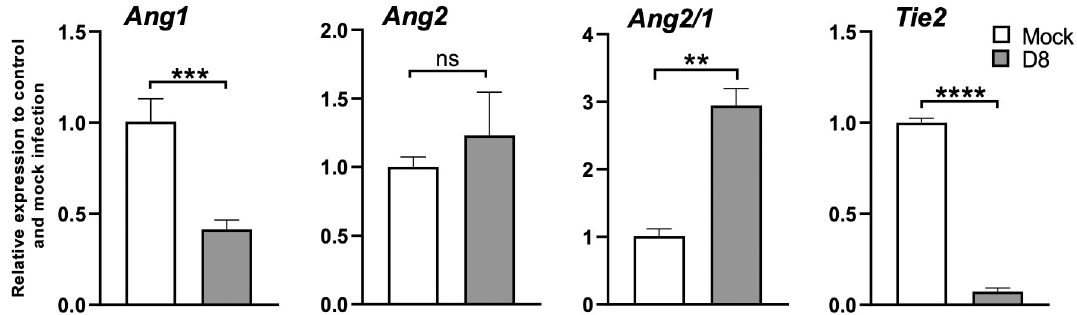
Fig 4. Lung endothelial dysfunction in CD-1 mice during acute infection. CD-1 mice were infected, as described in Fig 2. Lung tissues were collected from mock and day 8 infected mice (3–4 mice/group), and RT-qPCR assays were performed to measure Ang1 , Ang2 , and Tie2 levels, shown as relative to GAPDH values. The Ang2/Ang1 ratio of individual samples was calculated based on RT- qPCR data and compared to mock controls. Data are presented as mean ± SEM. Students T-test was used for statistical analysis. ns = not significant; �� , p < 0.01; ��� , p < 0.001; ���� , p < 0.0001.